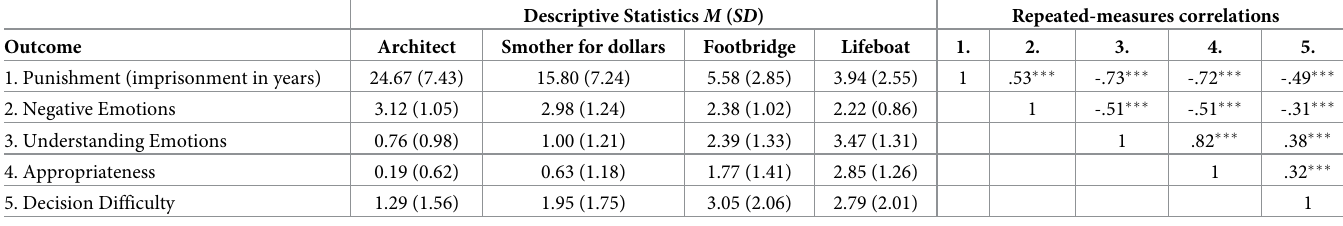
Table 2. Descriptive statistics and correlations of outcome